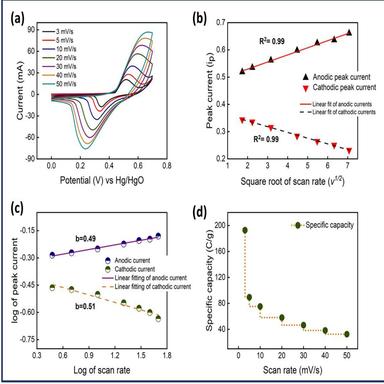
(a) Cu-B-MI-MOF's CV profile (b) Linear regression plot (c) Cu-B-MI-MOF electrode's b- values (d) Specific capacity extracted from CV analysis.